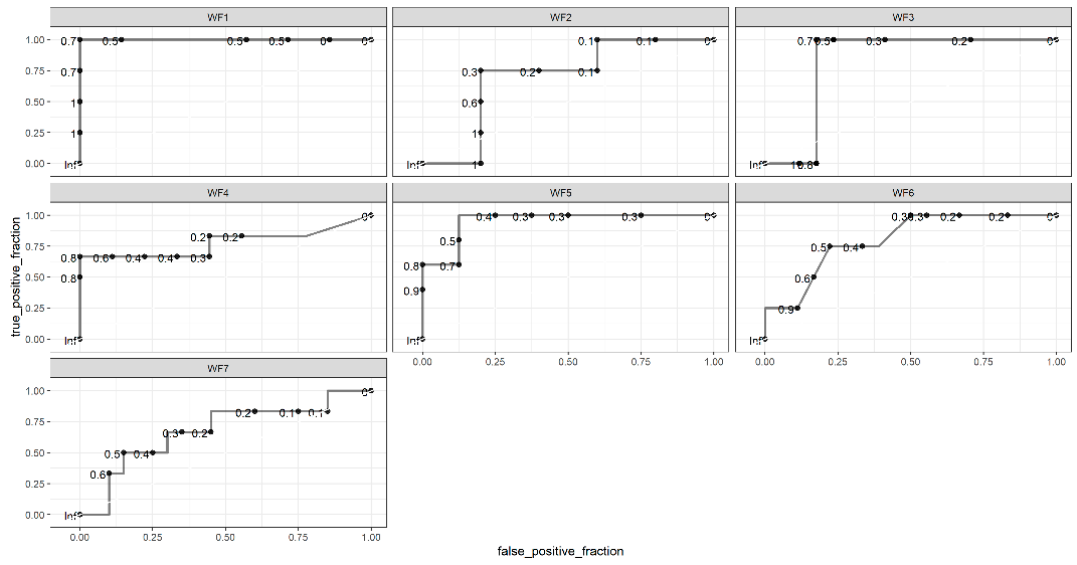
Figure 2. Receiving Operator Curve (ROC) of the various windfarms, the points and the corresponding values represent possible cutoff values to make a decision.